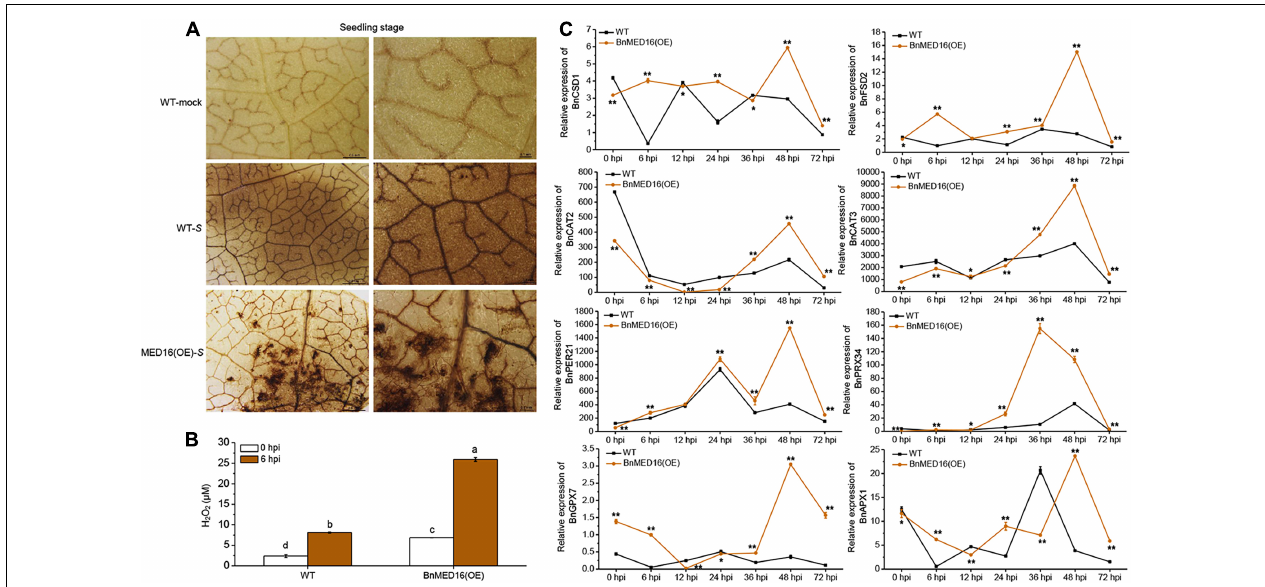
FIGURE 4 | H 2 O 2 accumulation and the expression levels of ROS-associated genes in response to S. sclerotiorum inoculation in BnMED16(OE) and WT of rapeseed. (A) Detection of H 2 O 2 accumulation by DAB staining in B. napus leaves at the seedling stage after S. sclerotiorum inoculation. The images show leaves at 6 hpi with either mock solution of S. sclerotiorum (S). Three biological replicates were used in this experiment; n ≥ 10 leaves were measured in each replicate. Bars, 0.5 mm (the first column) and 0.1 mm (the second column). (B) Determination of H 2 O 2 content of seedling leaves after inoculation as shown in (A) . The data are the mean ± SD of three independent biological replicates. Least-significant difference (LSD) tests were used for multiple comparisons. Different letters above bars indicate that the means differ according to ANOVA and LSD tests ( P < 0.01). (C) Expression pattern of BnCSD1 ( BnaA06g05150D ), BnFSD2 ( BnaA03g13310D ), BnCAT2 ( BnaA03g53180D ), BnCAT3 ( BnaA08g21730D ), BnPER21 ( BnaC03g20530D ), BnPRX34 ( BnaA01g20660D ), BnGPX7 ( BnaA03g51760D ), and BnAPX1 ( BnaA09g49190D ) in BnMED16(OE) and WT seedling leaves at different time points after inoculation with S. sclerotiorum . BnActin7 was used as the internal control; Data are means ± SD of three biological replicates and the asterisks denote statistical significance at P < 0.01 (**) or P < 0.05 (*) between the WT and BnMED16(OE) lines at each time point by Student’s t